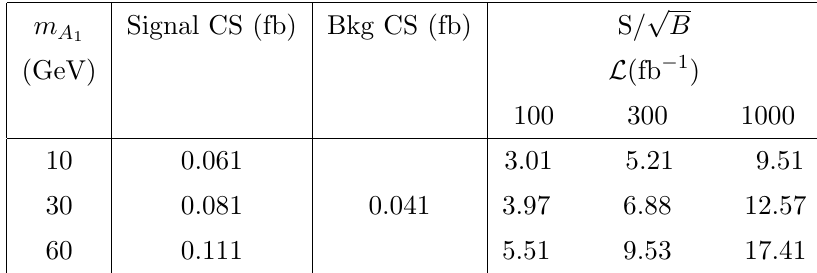
with (cid:12) = 10 (cid:0) 3 (see 1